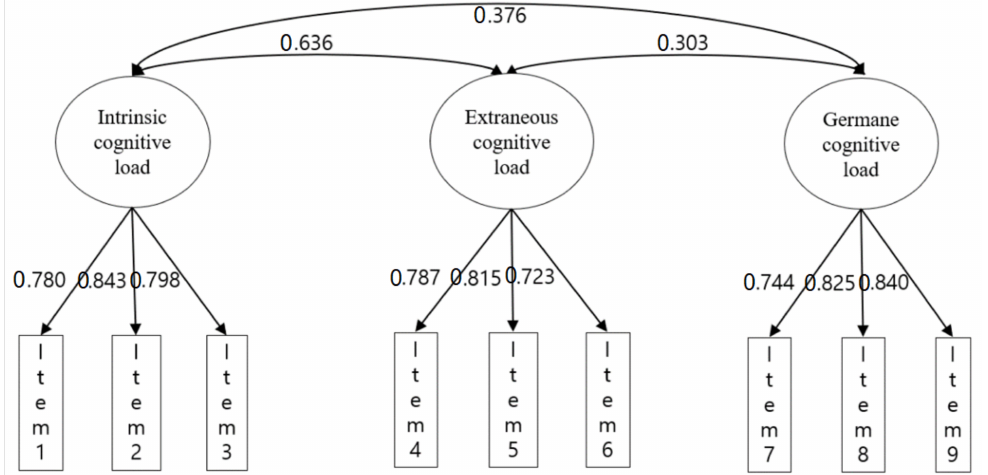
Figure 1. Internal structure of